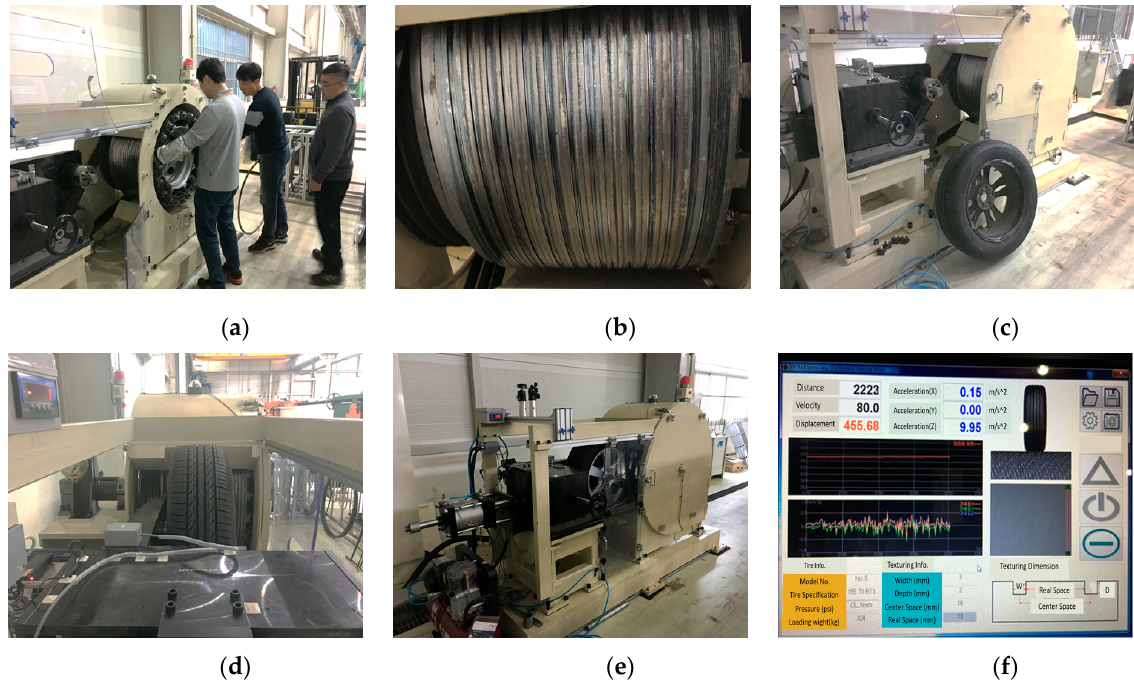
Figure 2. The procedure of the driving simulation test. ( a ) Install surface ring. ( b ) Complete texture. ( c ) Install the tire. ( d ) Move tire to the initial position. ( e ) Driving test and measurement. ( f ) Measurement result monitoring.